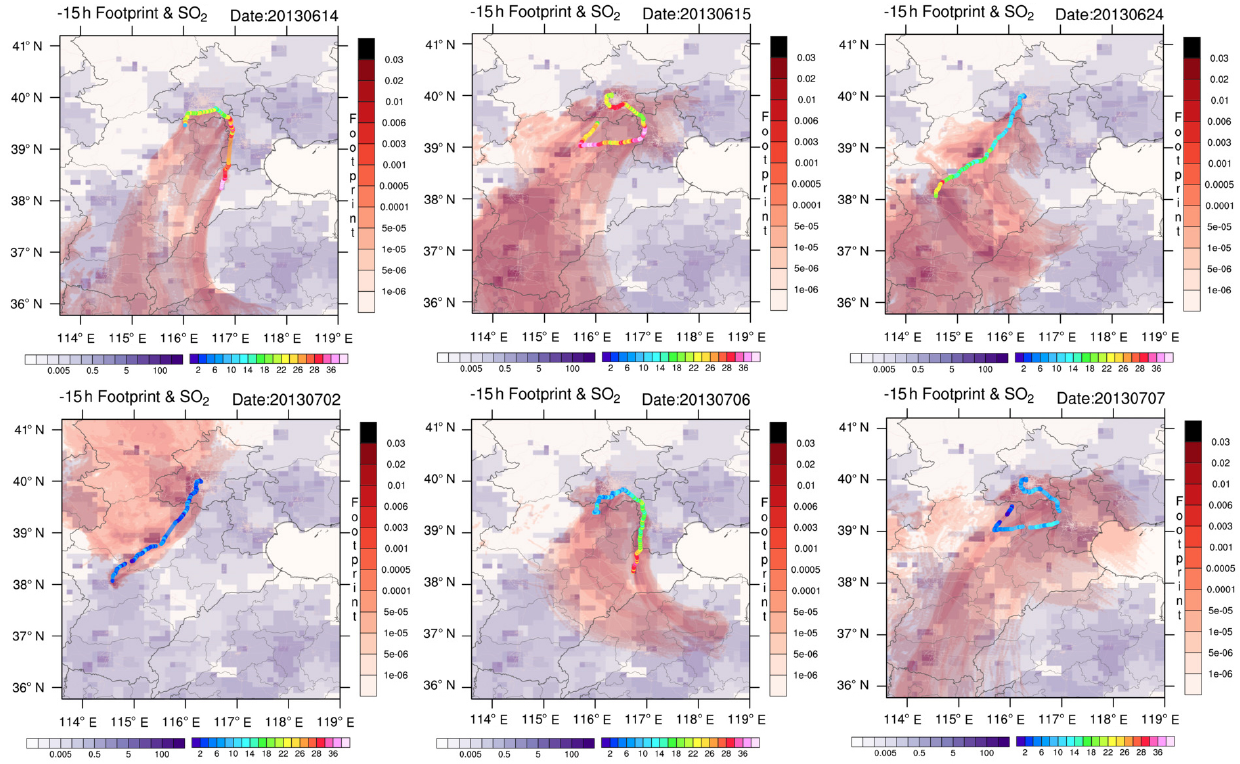
Figure 7. The back trajectories of observed air masses in the borders of the NCP on 14, 15 and 24 June and 2, 6 and 7